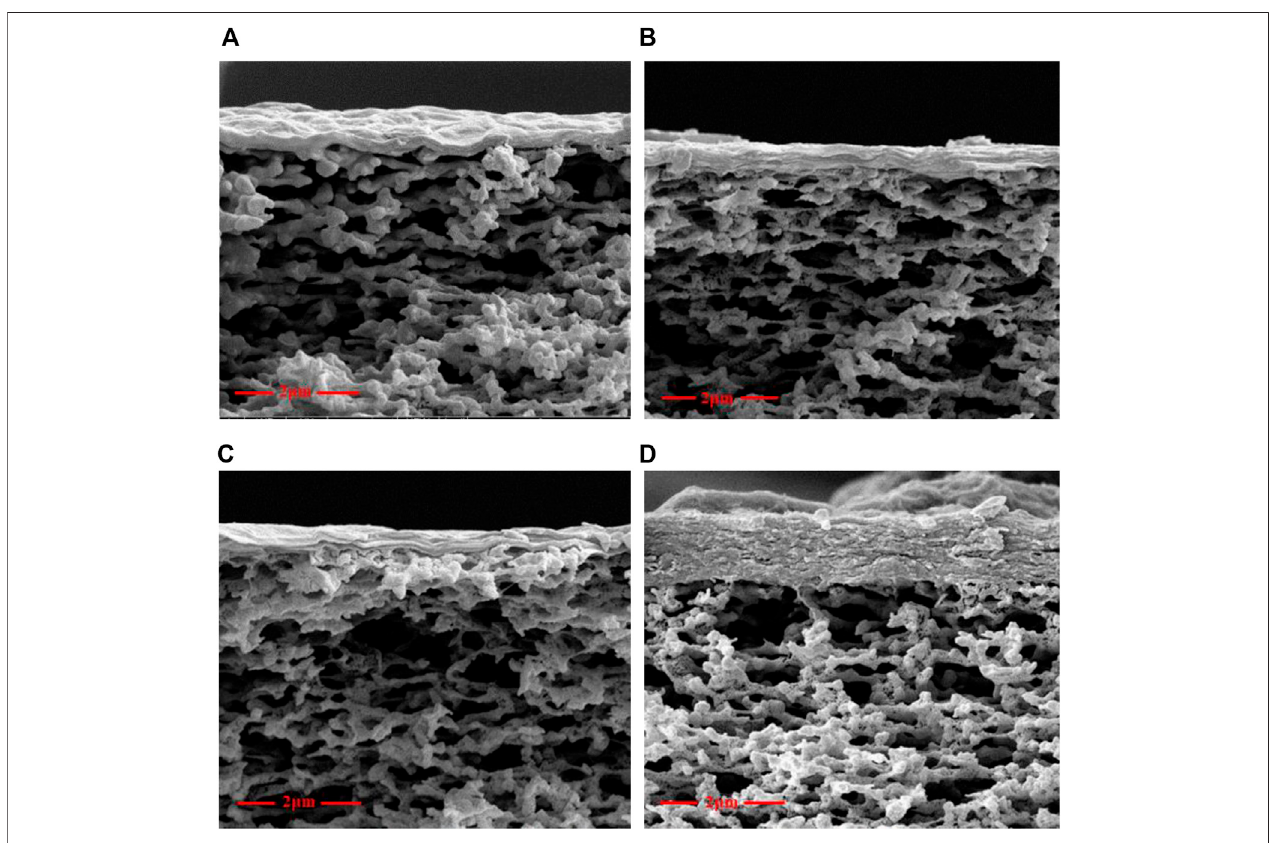
FIGURE 4 | Cross-sectional images of (A) GO, (B) GO-EDA, (C) GO-UR, and (D) GO-PPD.